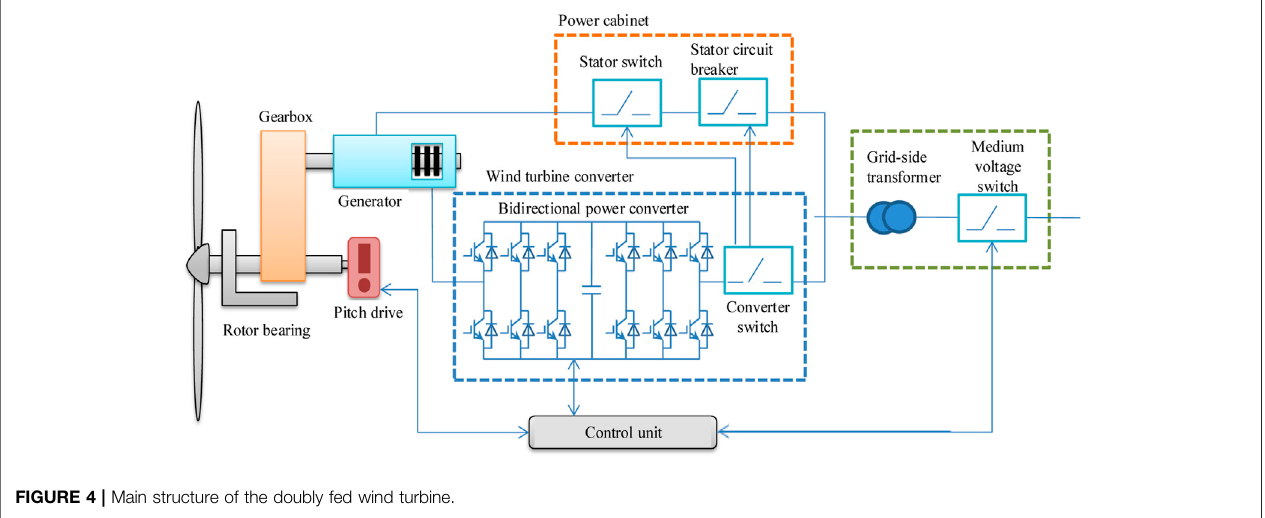
FIGURE 4 | Main structure of the doubly fed wind turbine.